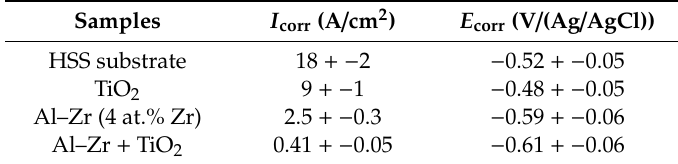
Figure 10. Polarisation curves of Al–Zr (4 at.% Zr), TiO 2 , and TiO 2 /Al–Zr bilayer films deposited on HSS after 1 h of immersion in 5 wt.% NaCl. Table 3. I corr and E corr values for Al–Zr, TiO 2 films, Al–Zr / TiO 2 films, and HSS substrate.